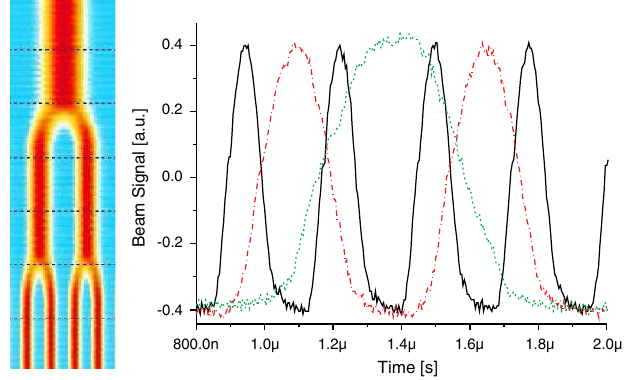
FIG. 7. Waterfall plot (left diagram) and bunch profiles (right diagram) before bunch merging (solid line), after 4:2 bunch merging (dash-dotted line), and after 2:1 bunch merging (dotted line).